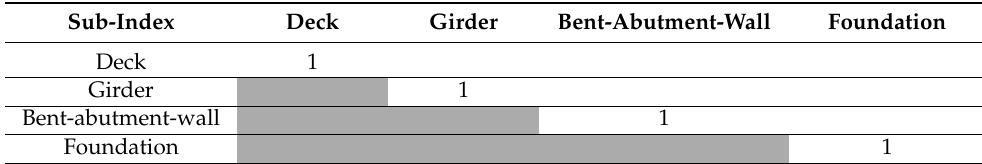
Table A2. Relative Importance of Sub-Indices in Structural index. Sub-Index Deck Girder Bent-Abutment-Wall Foundation Deck 1 Girder 1 Bent-abutment-wall 1 Foundation 1